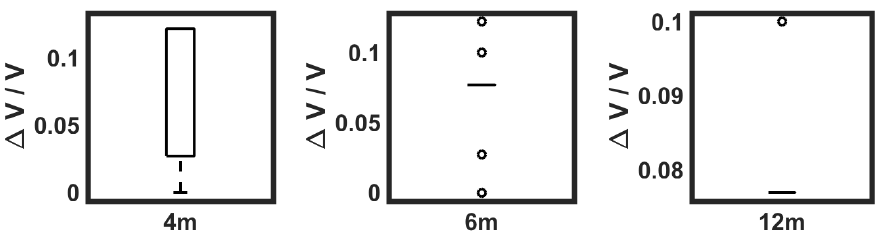
Figure 16. Sensor voltage output for aerial measurements at different